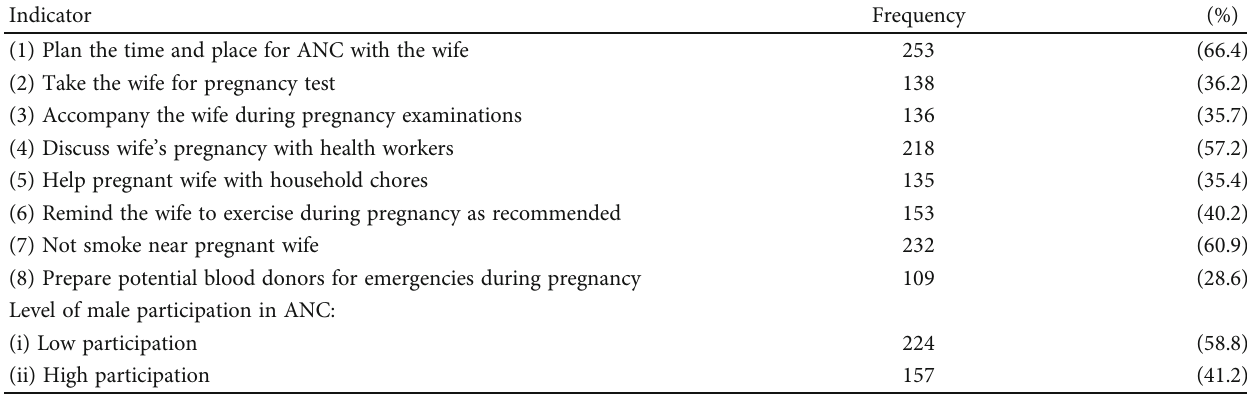
Table 2: Level of male participation in antenatal